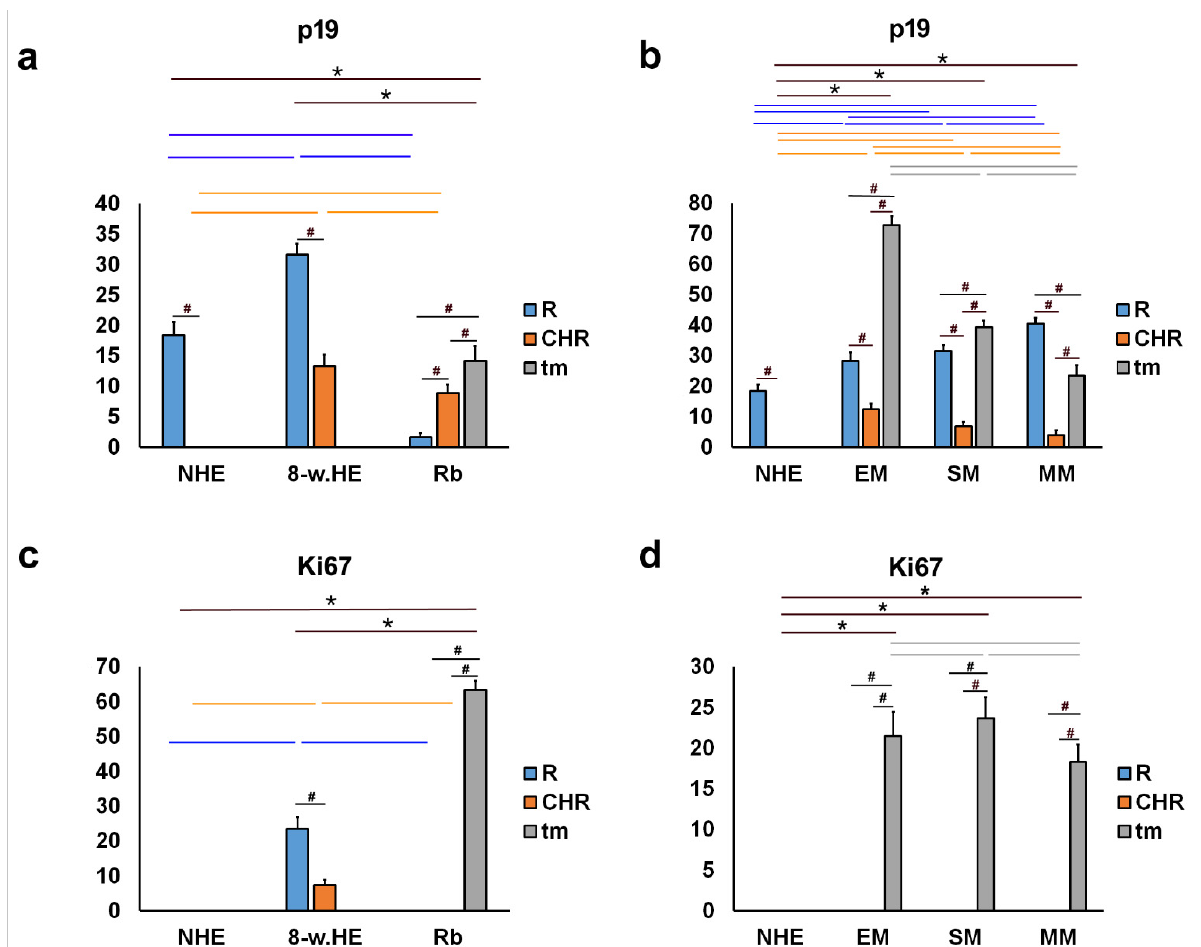
Figure 3. Quantitative analysis of p19 and Ki67 expression. Threshold area percentage of p19 and Ki67 in the normal human eye (NHE), the eye section of an 8-week human embryo (8-w.HE), retinoblastoma (Rb), epithelioid melanoma (EM), spindle melanoma (SM), and myxoid melanoma (MM). Data are shown as mean ± SD. #—statistically significant differences (comparison between retina, choroid and tumor in the same specimens); orange line—statistically significant differences- comparison of the choroid between NHE, 8-w.HE, tumor and different type of melanomas); blue line—statistically significant differences-comparison of the retina between NHE, 8-w.HE, tumor and different type of melanomas); grey line—statistically significant differences-comparison of the tumor tissue between different type of melanomas; *—statistically significant differences (comparison between Rb and retina or melanoma and choroid) (ANOVA and Tukey post-hoc test). All significant differences are presented in Supplementary Tables S1–S5.